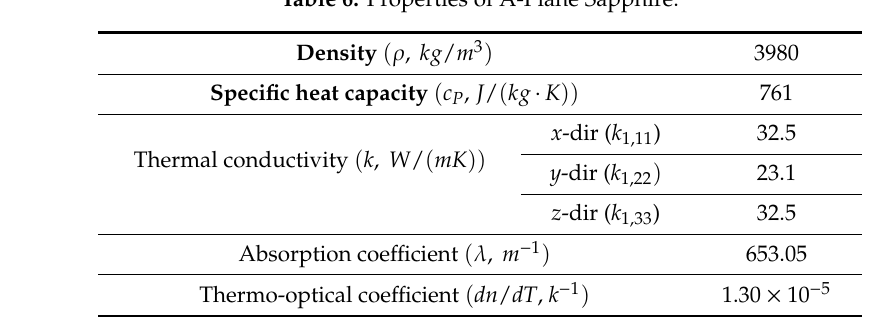
Table 6. Properties of A-Plane Sapphire.